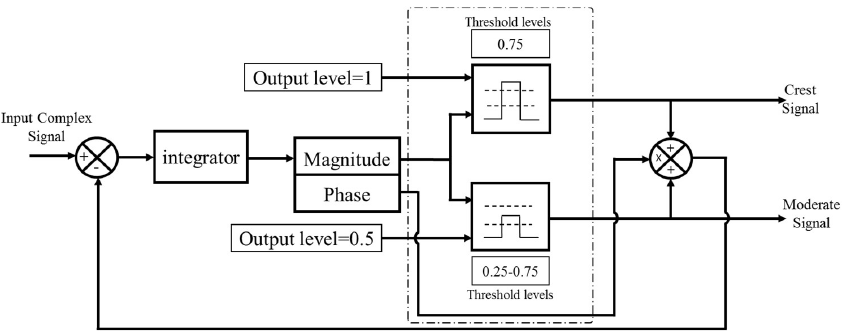
Figure 2. The three-level de-multiplexing quantization process.